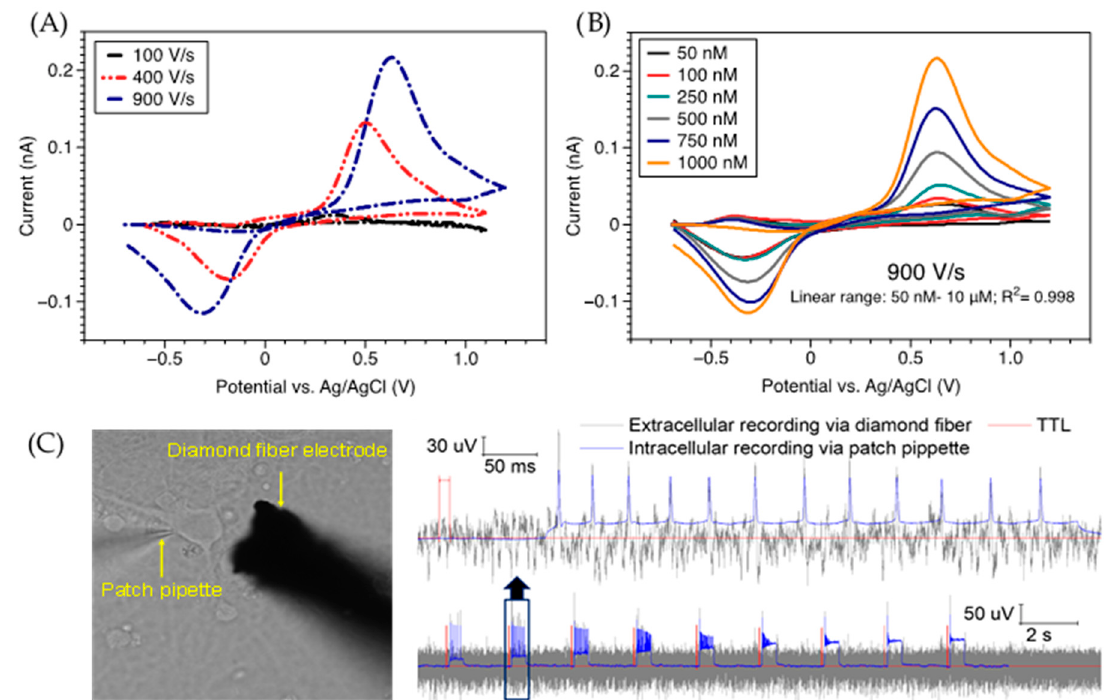
Figure 5. Data illustrating proof-of-concept of boron-doped diamond microelectrode (BDDME) performance as a sensor for neurochemical and electrical signals. Fast-scan cyclic voltammetry (FSCV) measurements validate the ability of diamond electrodes for rapid dopamine (DA) detection with good sensitivity and selectivity: ( A ) Scan rate study of 1.0 µ M DA using FSCV, color plot inlay for 900 V/s (100–1000 V/s investigated). ( B ) DA FSCV calibration at 900 V/s and 10 Hz. Linear range: 50 nM–10 μ M, R2: 0.998 (exemplary data shown). All experiments were completed in a stagnant cell containing pH 7.4 PBS. ( C ) Combined intra/extracellular recordings validate detectable spiking activity using the BDDME during stimulation through a patch pipette electrode.